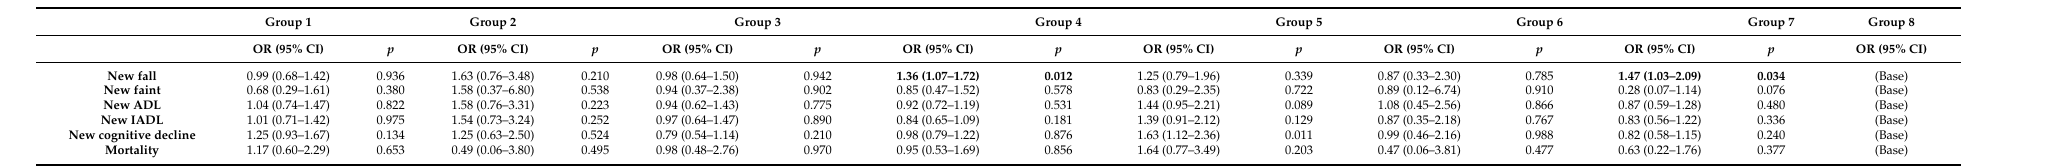
Table 2. Results of the fully adjusted logistic regression models (Models C). Statistically significant results are highlighted in